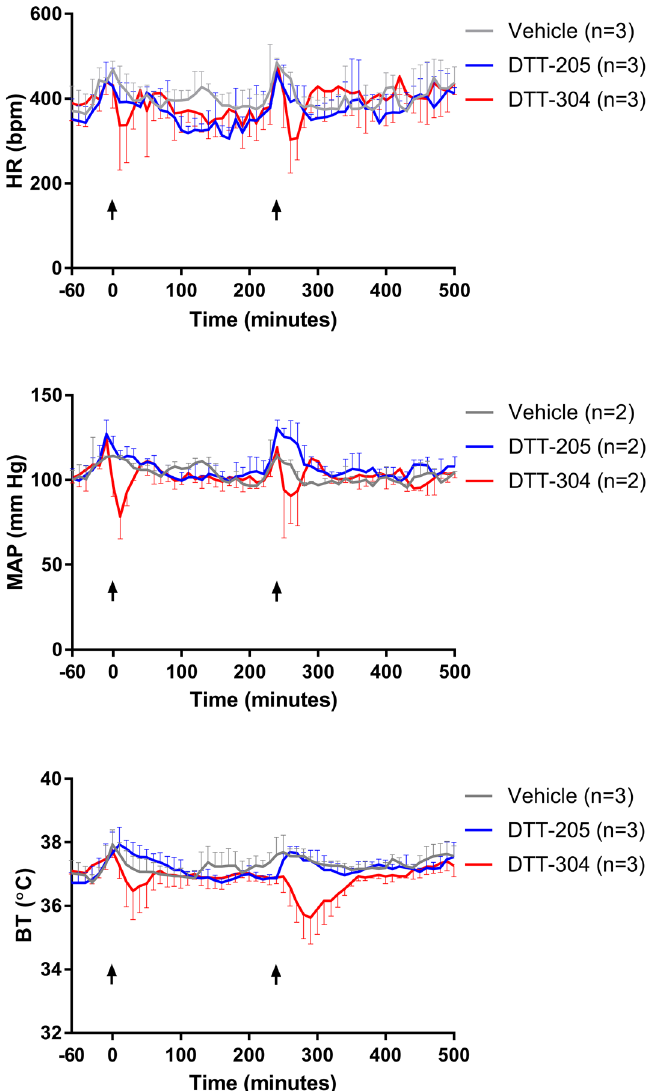
Figure 7. Cardiovascular and temperature assessment in rats after treatment with DTT-205 or DTT-304. Heart rate (HR), mean arterial pressure (MAP) and body temperature (BT) in rats treated with DTT-205 or DTT-304 in the period − 60 to 500 min after injection. Arrows indicate time of injection. Error bars indicate standard